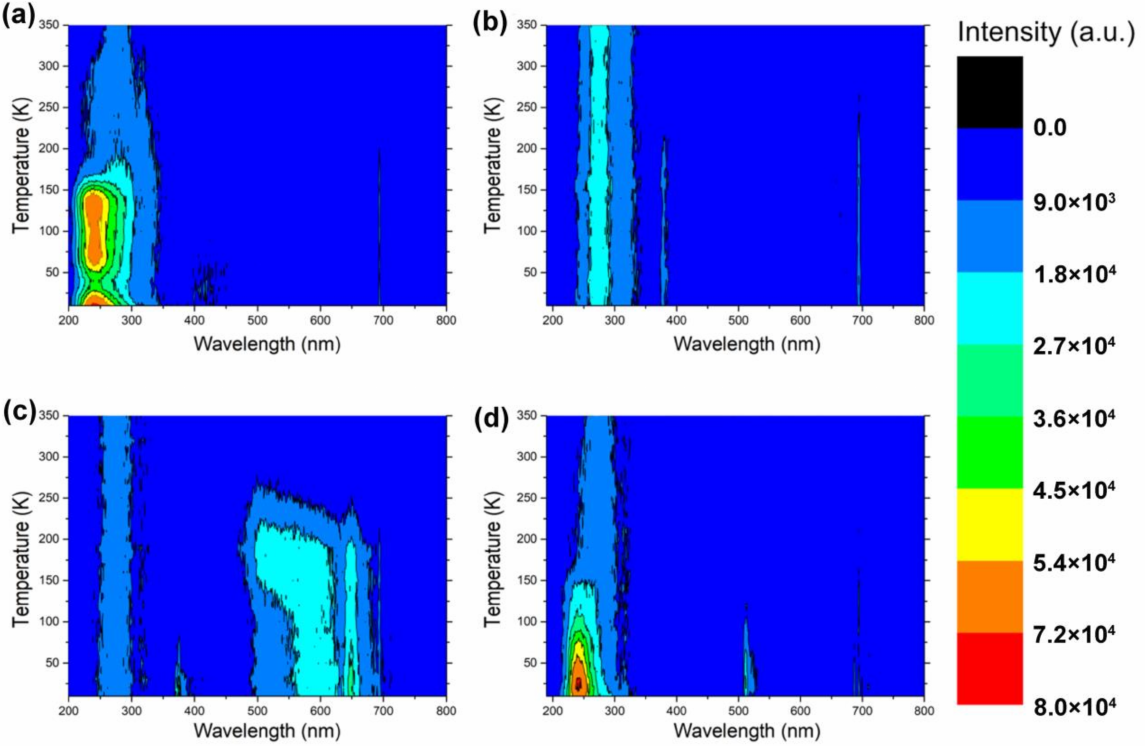
Figure 11. 2D radioluminescence maps of ( a ) the sapphire substrate, ( b ) 650_18 sample, ( c ) 800_50 sample, and ( d ) 1000_50